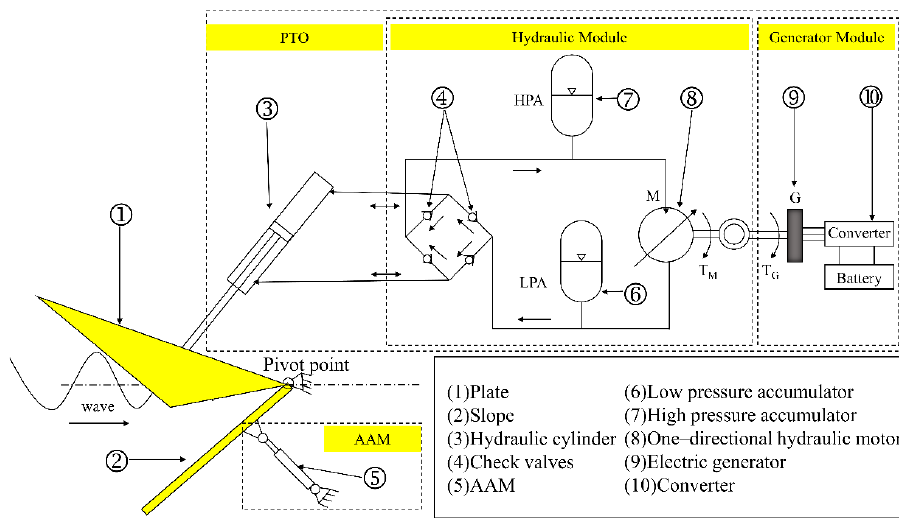
Figure 1. Structure schematic of S-PWEC. PTO Module: The part is mainly composed of a hydraulic system and generator, a floating plate under the action of wave excitation, and rotating movement around the fixed hinge pivot point, pushing the hydraulic rod. The hydraulic rod movement will compress the hydraulic cylinder and convert the mechanical energy of the floating plate into hydraulic energy. The hydraulic system is a hydraulic circuit consisting of a high- pressure accumulator (HPA), a low-pressure accumulator (LPA), and a check valve. Af- terward, the hydraulic energy will be converted into electrical energy using a generator and stored in a battery, or the electricity can also be directly integrated into the grid sys- tem. AAM Module: Different angular positions of the slope in the water have different effects on the reflection and transmission of the incident waves [16]. Under different sea conditions, the AAM system is used to adjust the position of the slope to make the best reflection of the incident waves, which allows the floating plate to absorb as much wave energy as possible to maximize the power output. When the S-PWEC model does not have a slope structure, it is defined as NS-PWEC in this article. 2.2. Motion Response Based on the Cummins time domain equation [17], and considering the floating plate viscous effect [12], the motion response equation of the floating plate to the pivot point can be obtained: ( 𝐼𝐼 + 𝐴𝐴 55 ( ∞ )) 𝜃𝜃̈ = 𝑀𝑀 𝑒𝑒𝑒𝑒 − � 𝐾𝐾 𝑅𝑅 ( 𝑡𝑡 − 𝜉𝜉 ) 𝜃𝜃̇ ( 𝑡𝑡 ) 𝑑𝑑𝜉𝜉 𝑡𝑡 0 + 𝑀𝑀 𝑏𝑏 − 𝑀𝑀 𝐺𝐺 + 𝑀𝑀 𝑣𝑣𝑣𝑣𝑣𝑣 + 𝑀𝑀 𝑃𝑃𝑃𝑃𝑃𝑃 (1) In the above equation: 𝜃𝜃 , 𝜃𝜃̇ , and 𝜃𝜃̈ are the angular displacement, angular velocity, and angular acceleration of the device moving at the pivot point, respectively. 𝐼𝐼 and 𝐴𝐴 55 ( ∞ ) are the moment of inertia of the device and the additional moment of inertia at infinite frequency, respectively. ∫ 𝐾𝐾 𝑅𝑅 ( 𝑡𝑡 − 𝜉𝜉 ) 𝜃𝜃̇ ( 𝑡𝑡 ) 𝑑𝑑𝜉𝜉 𝑡𝑡 0 is the convolution term of the radiation moment, which repre- sents the memory effect of the fluid, where 𝜉𝜉 is a small time step.